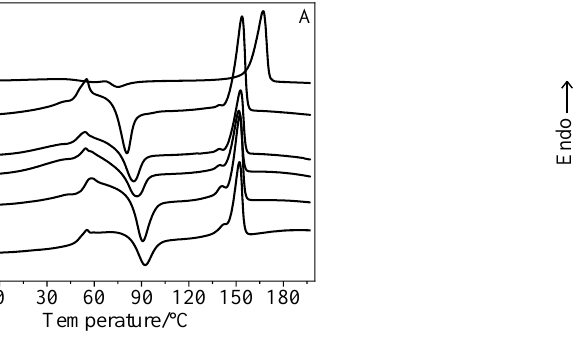
Figure 2. DSC curves of neat PLA and the PLA/thermoplastic starch/SiO 2 composite. ( A ) The composites with a thermal history; ( B ) the composites without a thermal history. Curve (a) is for 10 parts, (b) is for 15 parts, (c) is for 20 parts, (d) is for 25 parts, and (e) is for 30 parts of thermoplastic starch.